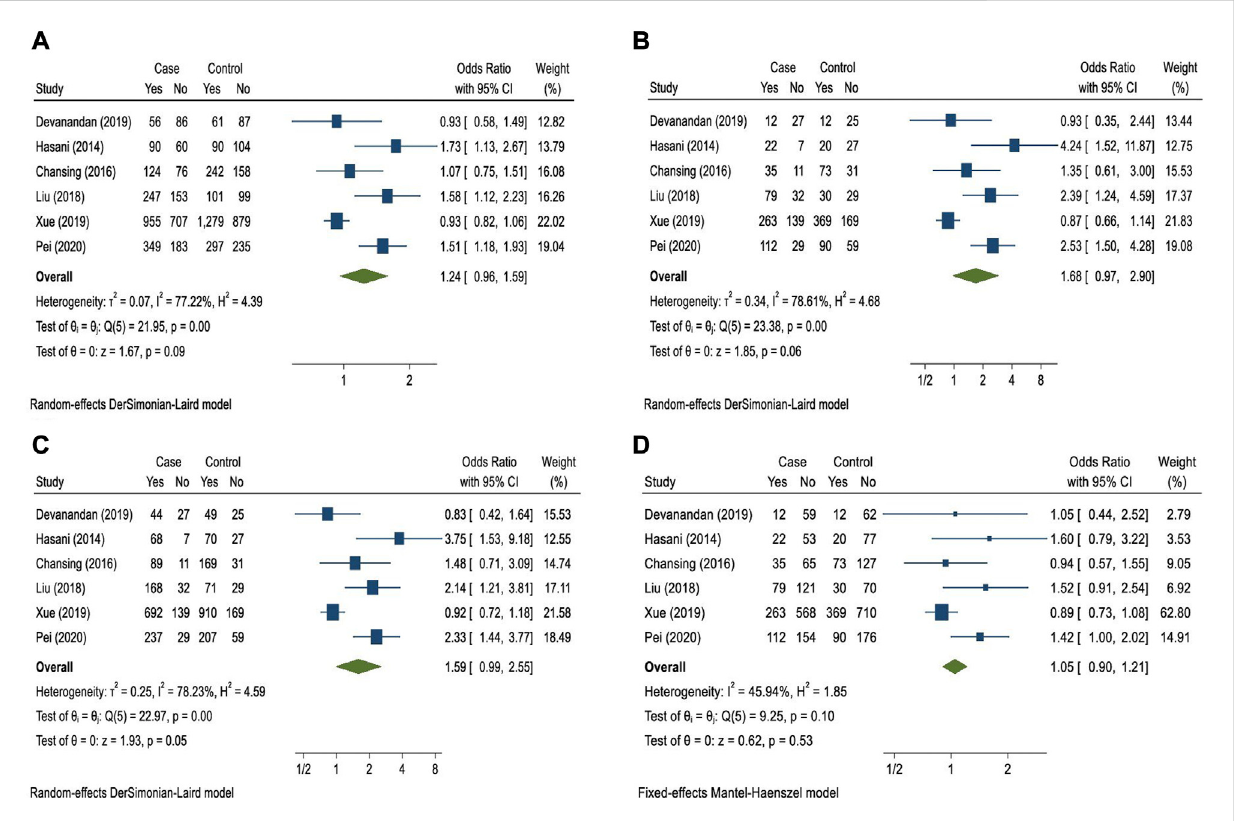
Forest plots for the allele (A) , additive (B) , dominant (C) , and recessive (D) models of the relationship between the miR-146a rs2910164 polymorphism and the risk of childhood acute lymphoblastic